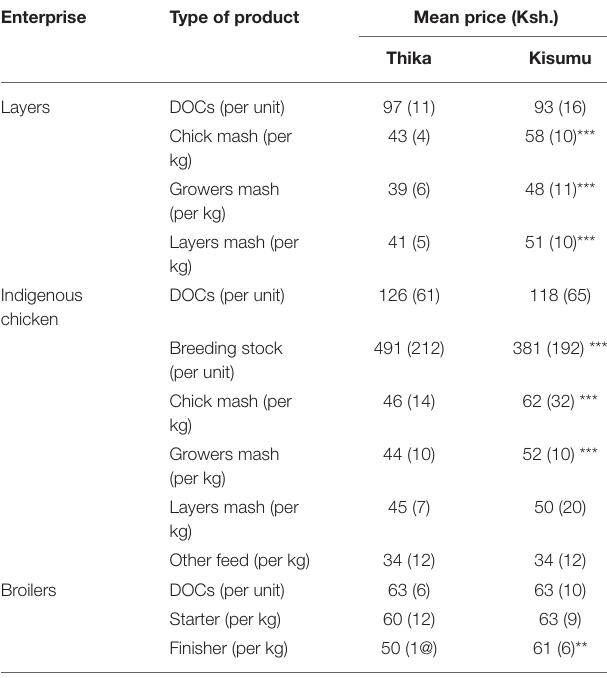
TABLE 5 | Mean prices of poultry inputs in Thika and Kisumu, 2016.